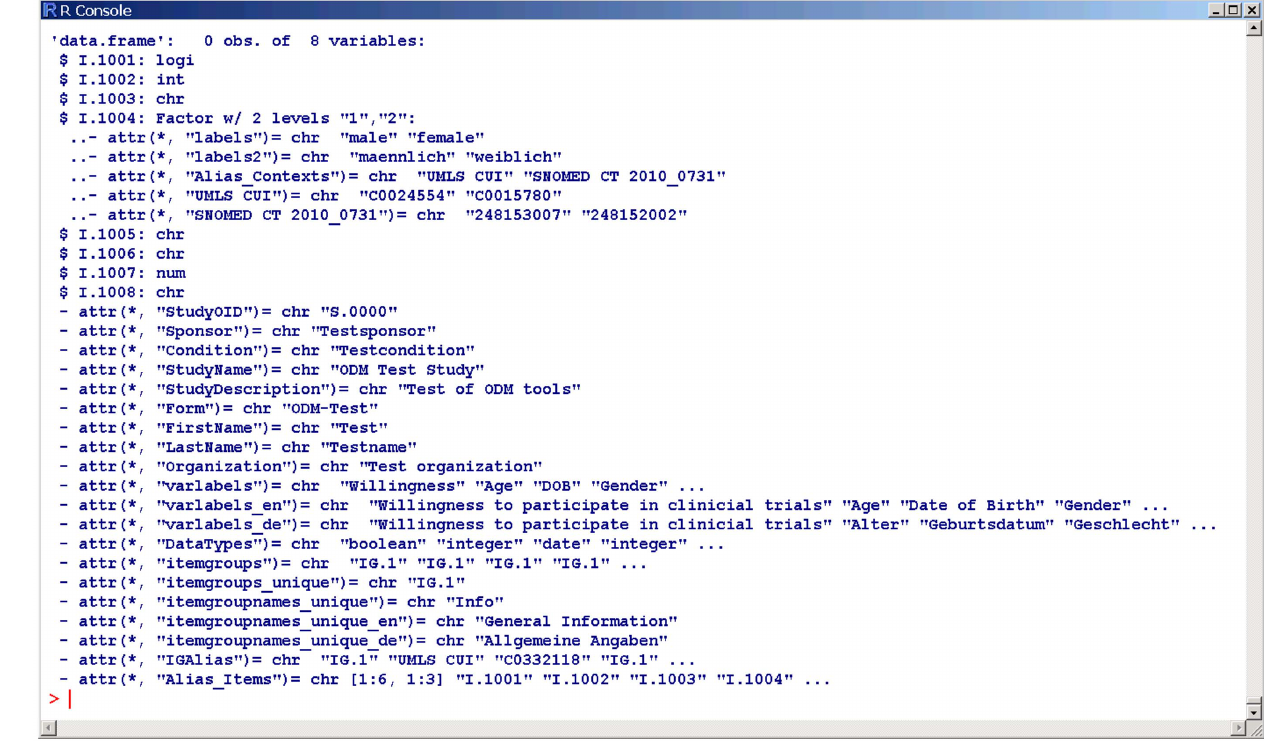
Figure 2. Example of data model in statistics format. An R data frame is provided with 8 variables (I.001 … I.008). Labels for variables and permissible values are defined, for instance ‘‘male’’ and ‘‘female’’ for item I.1004 (Gender). General information about the study like ‘‘StudyName’’ is provided as attribute of this data frame.